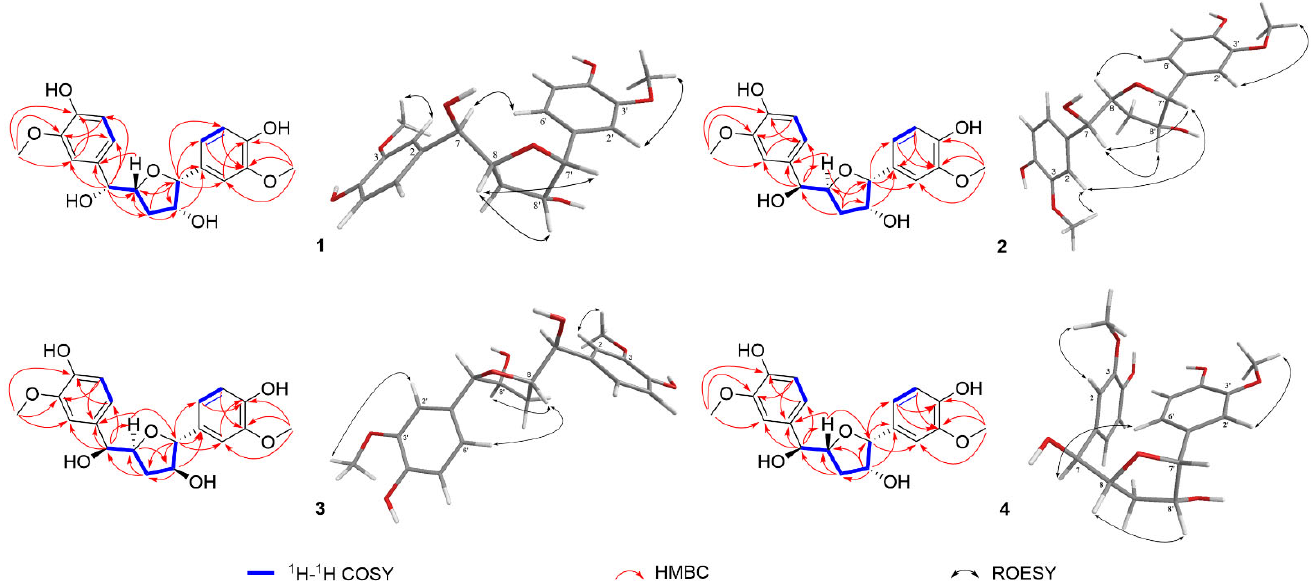
Figure 2. Key 2D NMR correlations of compounds 1 – 4 .